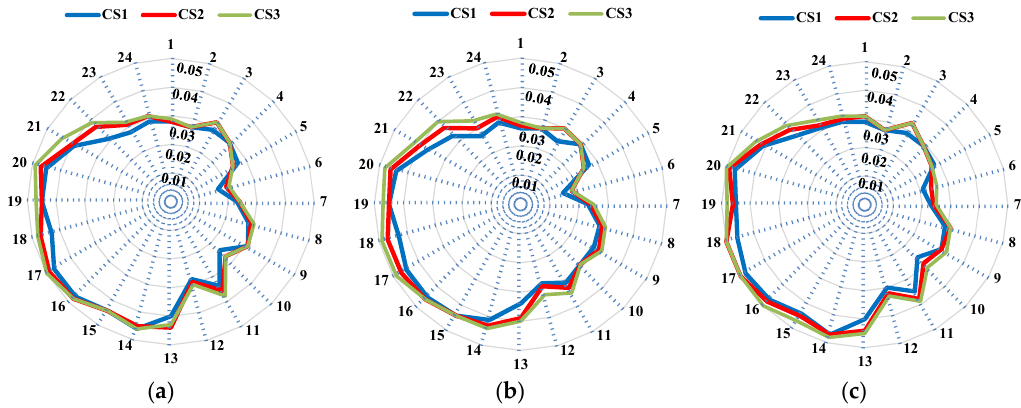
Figure 14. The maximum voltage deviation of buses for CS1, CS2 and CS3 in: ( a ) scenario 1; ( b ) scenario 2 and ( c ) scenario 3.